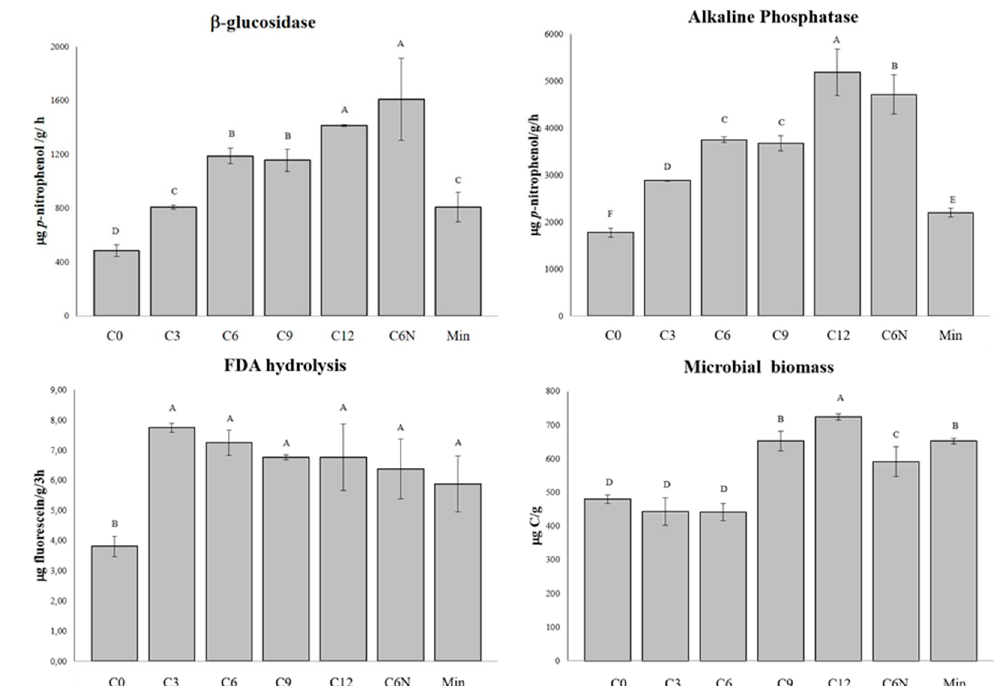
Figure 3. Enzymatic activities and microbial biomass of the potting soils amended for three-years with increasing doses of sewage sludge compost and supplied by mineral fertilization. C0, unfertilized soil; C3, C6, C9 and C12 = 3, 6, 9 and 12 Mg/ha sewage sludge compost, respectively; C6N, combined application of 6 Mg/ha of sewage sludge and 60 kg/ha N; Min, mineral fertilization. The values with the same letter are not significantly different, according to the SNK test at p ≤ 0.01. Vertical bars represent the standard errors of means.